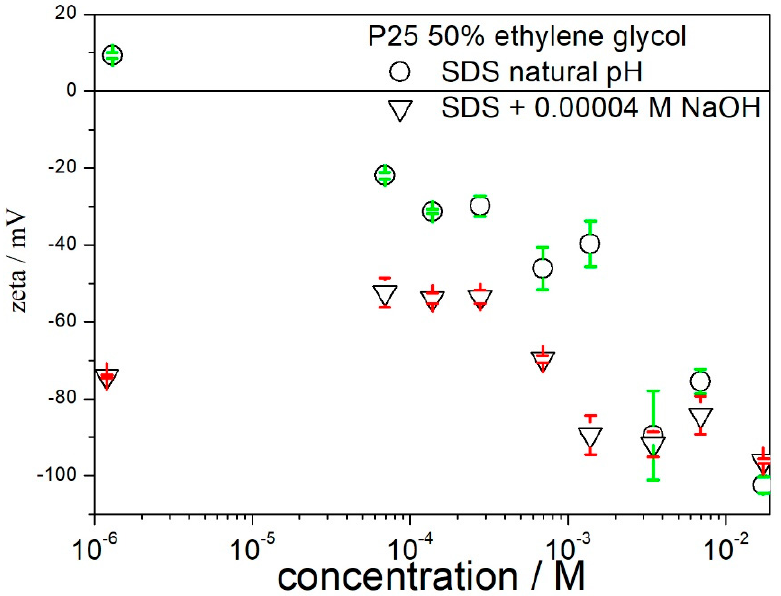
Figure 4. The effect of acidity on the zeta potential of titania in 50% EG in the presence of